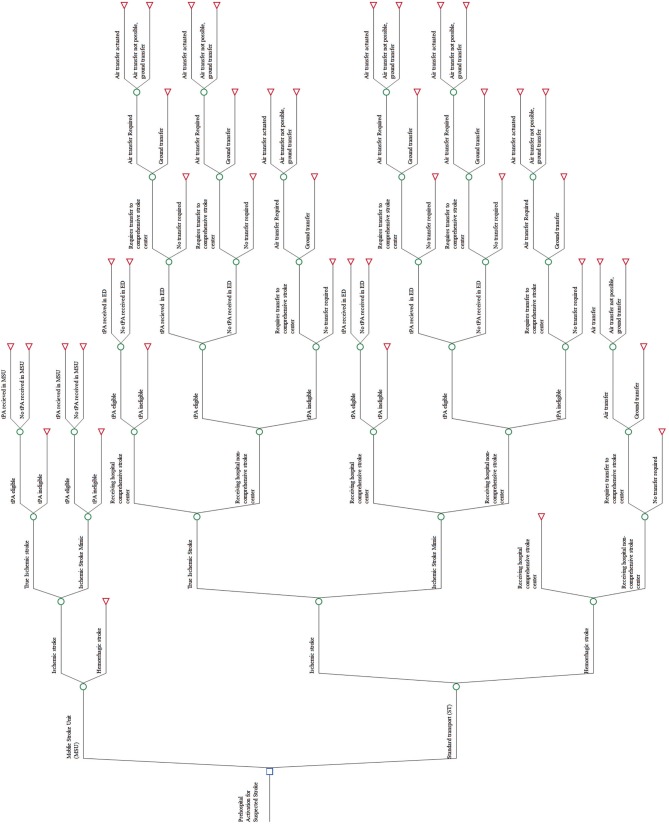
Skeleton decision tree.